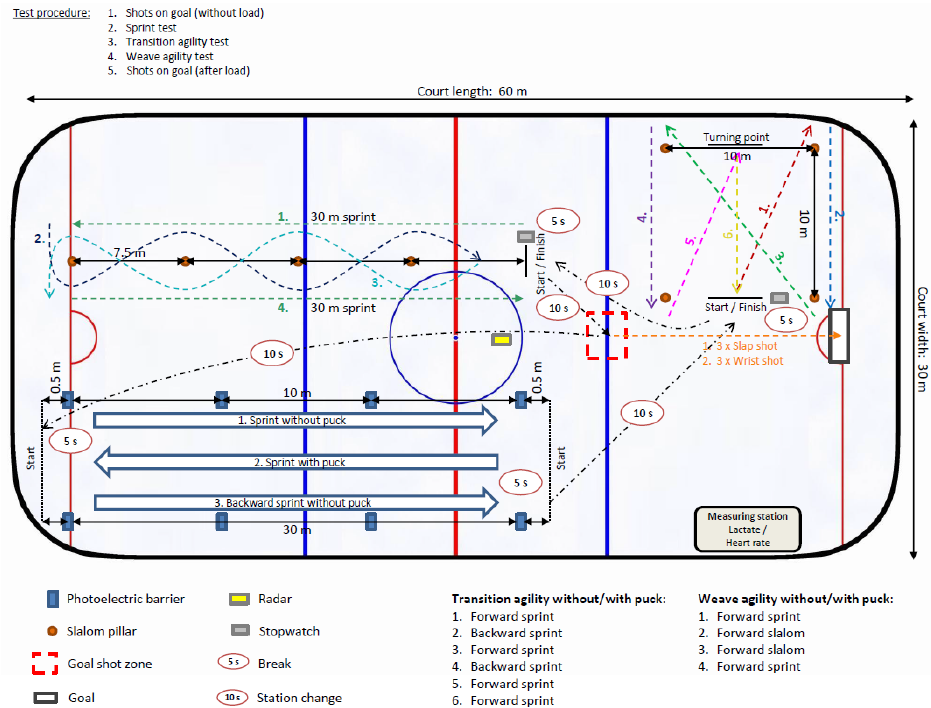
Figure 1. Schematic diagram of the ice hockey-specific complex test (IHCT) and description of the test sequences [10]. All players were assessed on the same day, and the tests were performed in the same order. The order of the different tasks had no influence on the intrarater reliability of the tasks and parameters. Schwesig et al. [17] found no differences for the last skating tasks (weave agility without and with the puck). Only the 10 m backward sprint without a puck displayed a markedly reduced reliability (ICC = 0.54, coefficient of variation (CV) = 9.2%). Reliability was slightly reduced for three parameters (10 m sprint with puck, slap shot 3 before test, slap shot 1 after test) (ICC: 0.60–0.73; CV: 5.0–8.3%)